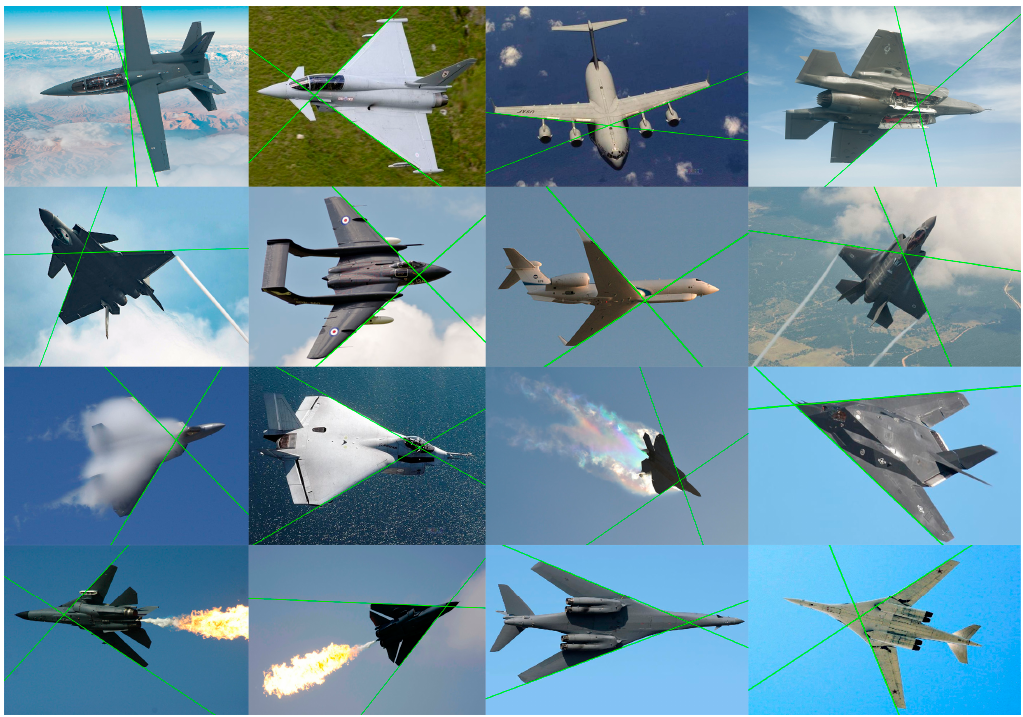
Figure 8. The results of the wing leading edge extraction. Sensors 2019 , 19 , x FOR PEER REVIEW